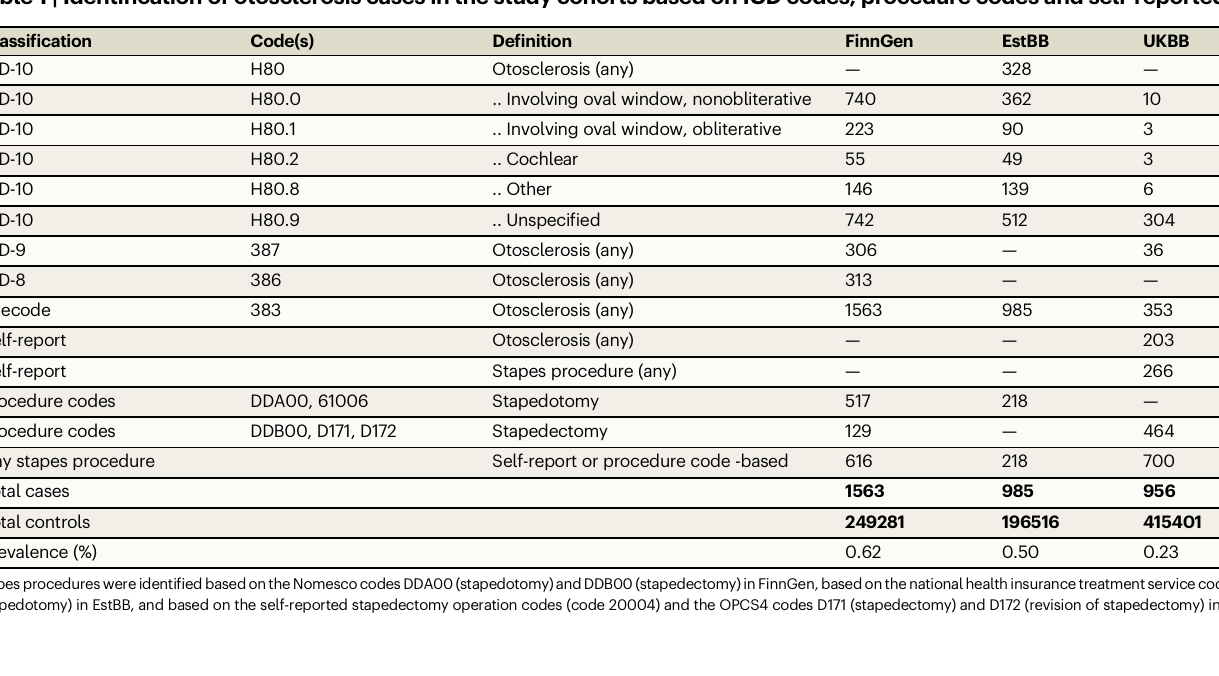
signi fi cance (two-sided p -value < 5×10 − 8 to account for multiple comparisons, marked by the dashed line). The included variants were present in at least two cohorts with a cross-cohort minor allele frequency > 0.1% and imputation INFO score ≥ 0.7.Thelociareannotatedbythenamesofthecodinggenesnearesttothe lead variants. The exact p -values corresponding to lead variants in each locus are presented in Table 2. Blue and gray colours are used to visually separate